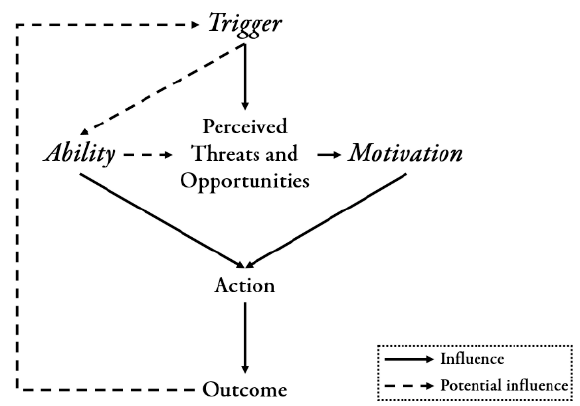
Figure 4. MOTA framework (Source: [23]